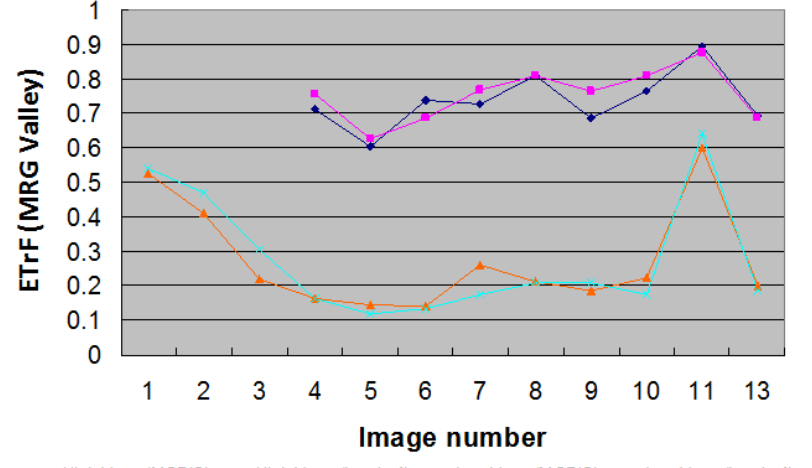
Figure 13. MODIS and Landsat based average ET (NDVI = 0.50 or higher) and low vegetation (NDVI = 0.20 and lower) along the Middle Rio Grande valley corridor during 2002, sampled with 2 km